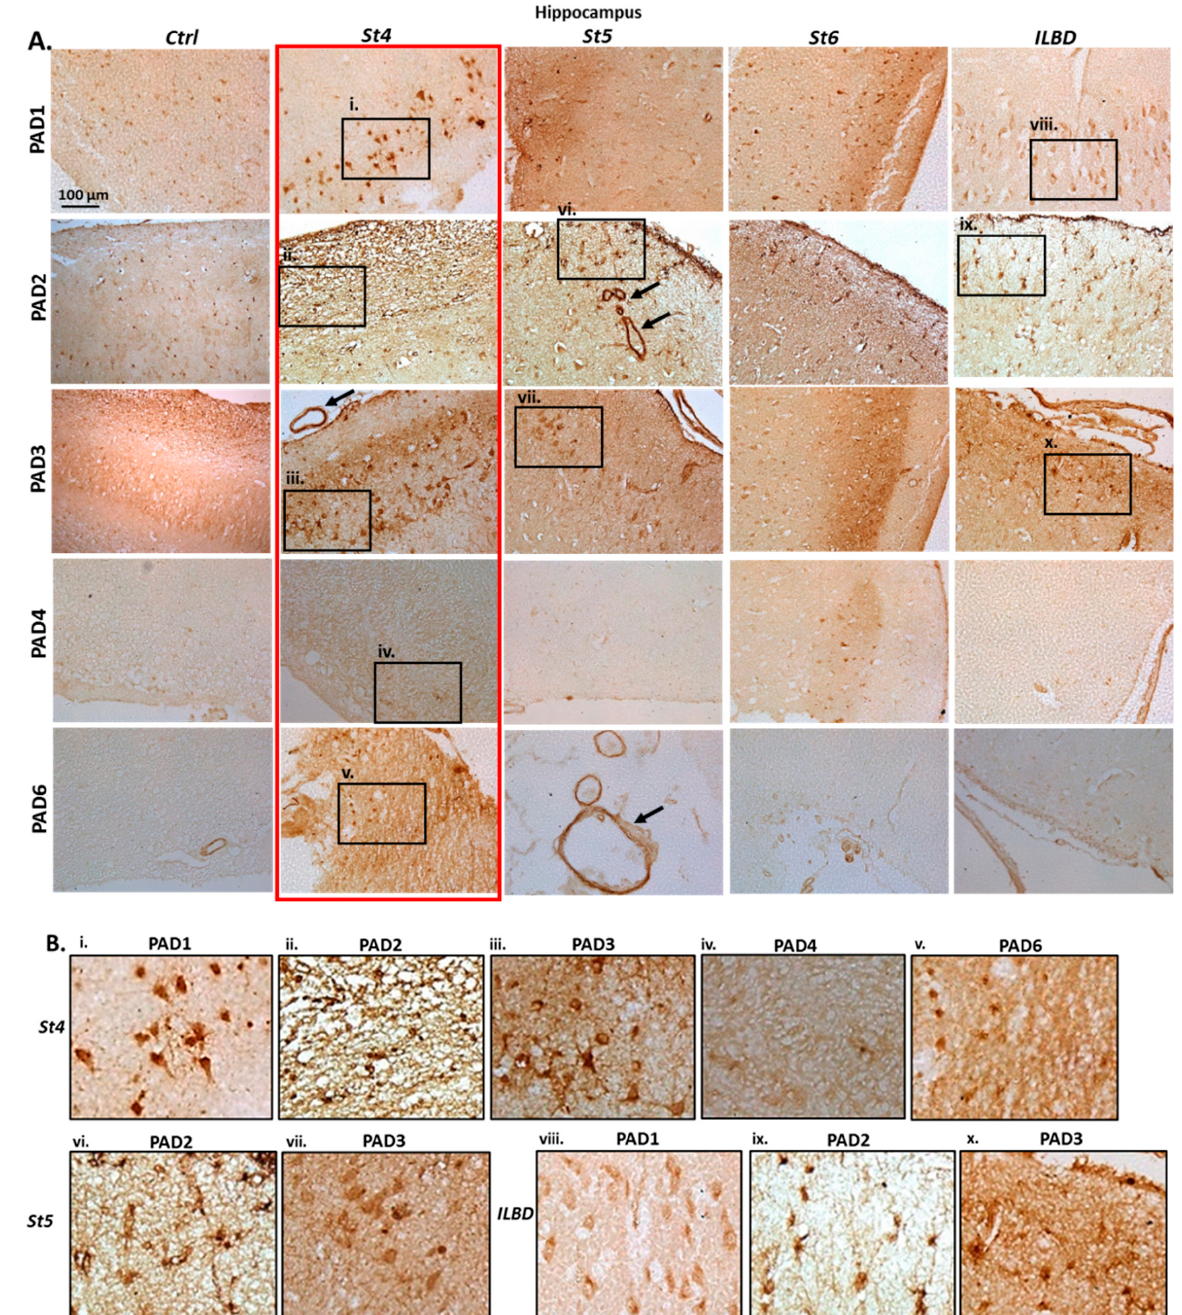
Figure 2. PAD isozyme (PADs 1–6) detection by immunohistochemistry in hippocampal tissue sections of post-mortem human PD brains. ( A ) Braak stages 4, 5, 6 and ILBD, Highest PAD levels are observed at earlier PD stages, notable at stage 4 (as highlighted by the red rectangle). Detection of PADs 1–3 is also notable in brain with ILBD. Scale bar represents 100 μ m. Black arrows point to positively stained brain vasculature. The black boxes (i–x) indicate areas that are further magnified in B. ( B ) (i–x): strong detection of PAD1, PAD2 and PAD3, as well as notable detection of PAD6 at Braak stage 4 (St4) is observed. PAD2 and PAD3 positive detection is clear at Braak stage 5 (St5). In brains with ILBD, PAD1 was clearly detectable, and both PAD2 and PAD3 showed strong positive